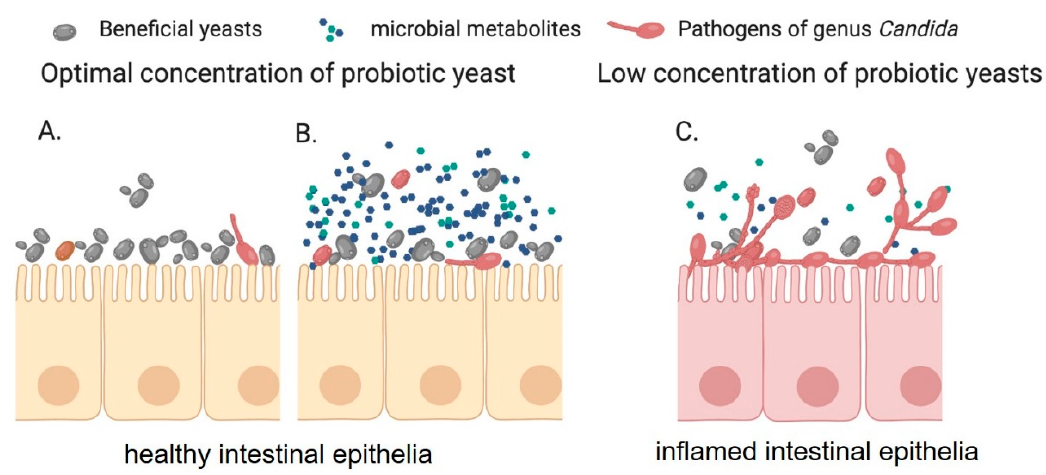
Figure 1. Probiotic yeast either form a physical barrier on epithelial surfaces ( A ) or secretes bioactive metabolite ( B ) to inhibit the adhesion and morphological transition of Candida species on epithelial cells. Further, suitable probiotic yeasts cell number is required for the effective inhibition of Candida virulence in the host GI tract ( C ).